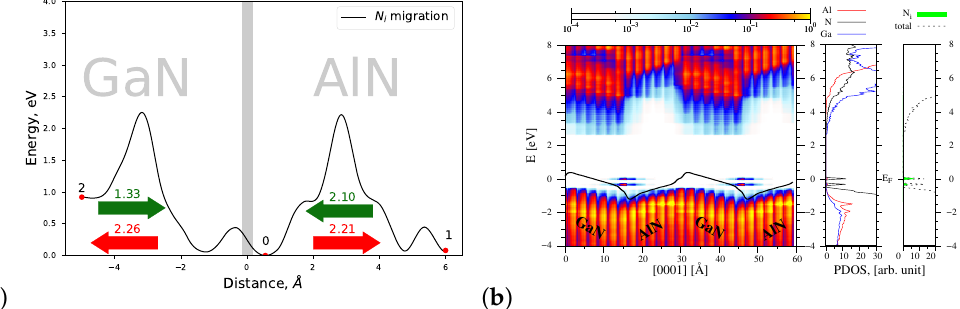
Figure 8. ( a ) Joint profile of the migration energy barrier of nitrogen interstitial N i at the AlN/GaN strained interface type, ( b ) the density of states projected on the atom quantum states (PDOS), showing the spatial variation of the valence and conduction bands in the GaN/AlN heterostructure, as well as the total DOS and PDOS functions associated with Al, N and Ga atoms, denoted by red, black, and blue lines, respectively. The green shade represents PDOS resulting from N i